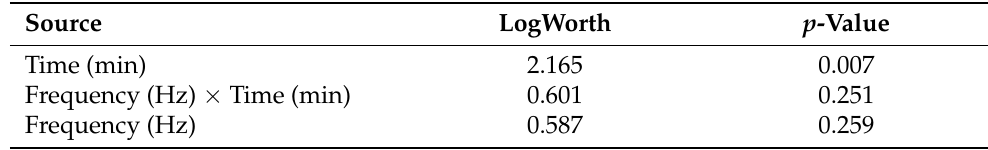
Table 1. Summary of response surface.